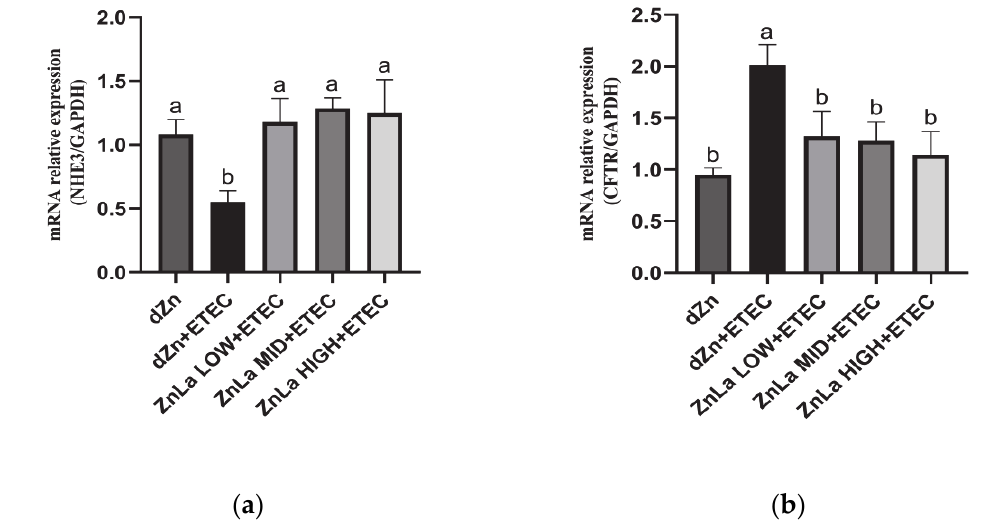
Figure 6. Effect of ZnLa on ion absorption and secretion in mice challenged with ETEC. Relative